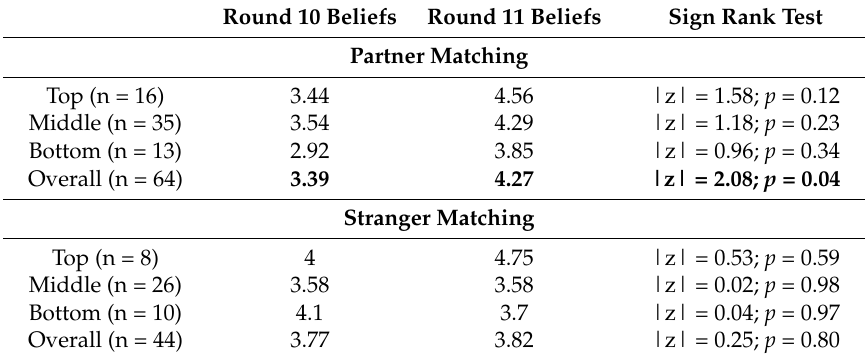
Table 6. Beliefs following restart, by type.